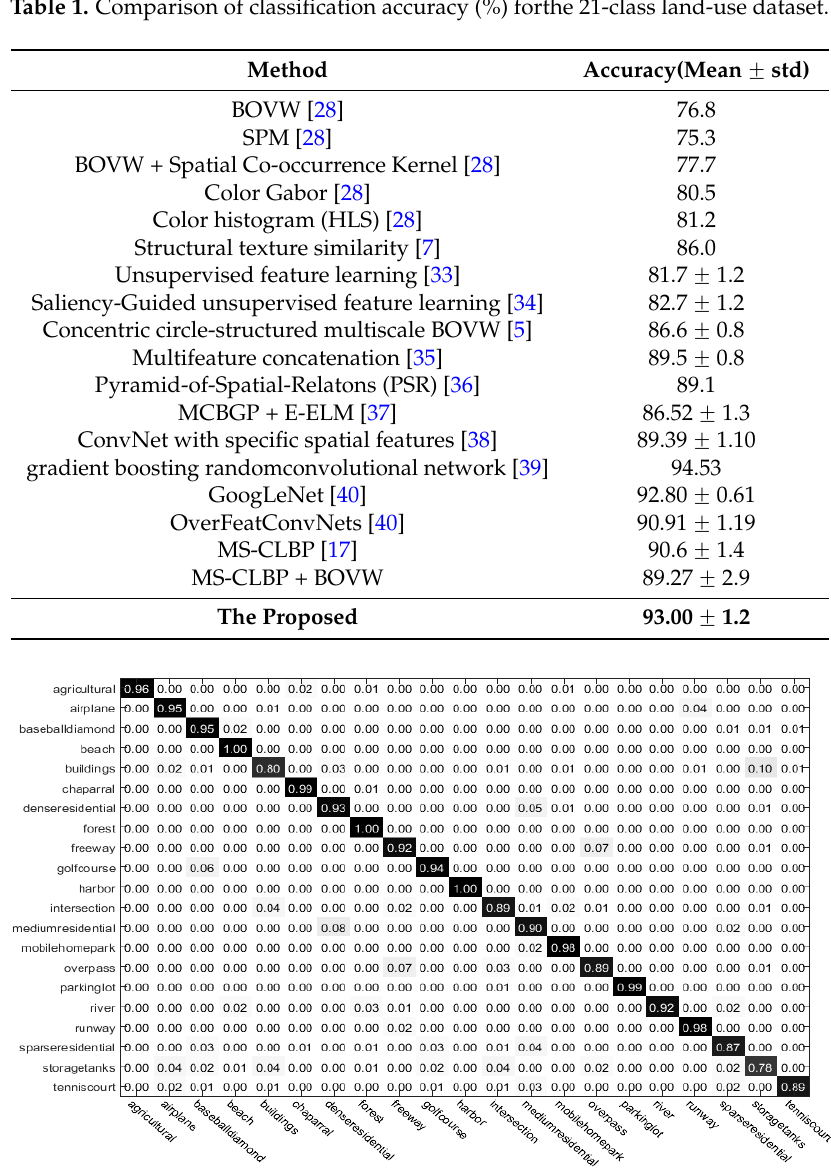
Figure 14. Confusion matrix of proposed method for the 21-class land-use dataset.